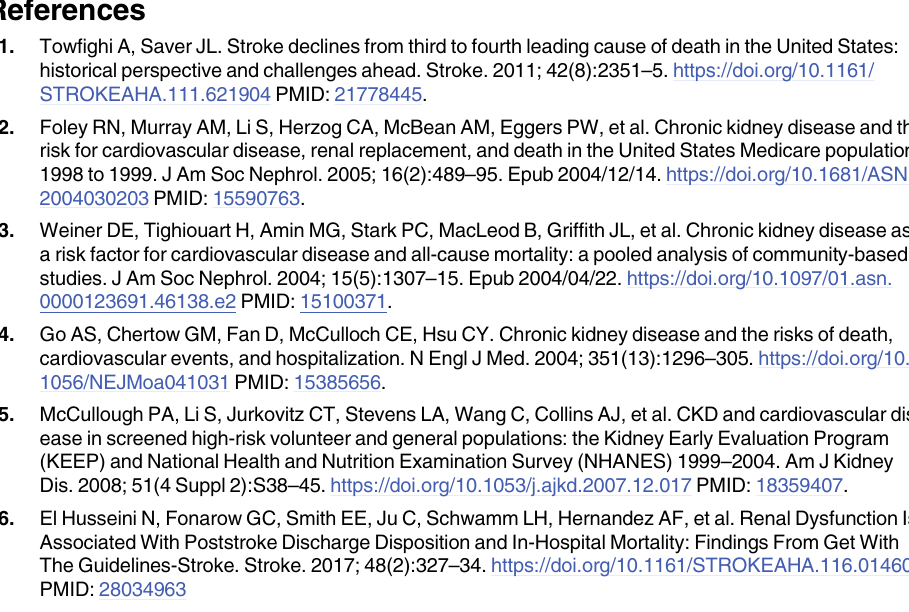
S1 Table. Baseline characteristics of excluded patients with intracerebral hemorrhage by eGFR levels on admission. S2 Table. List of Taiwan stroke registry